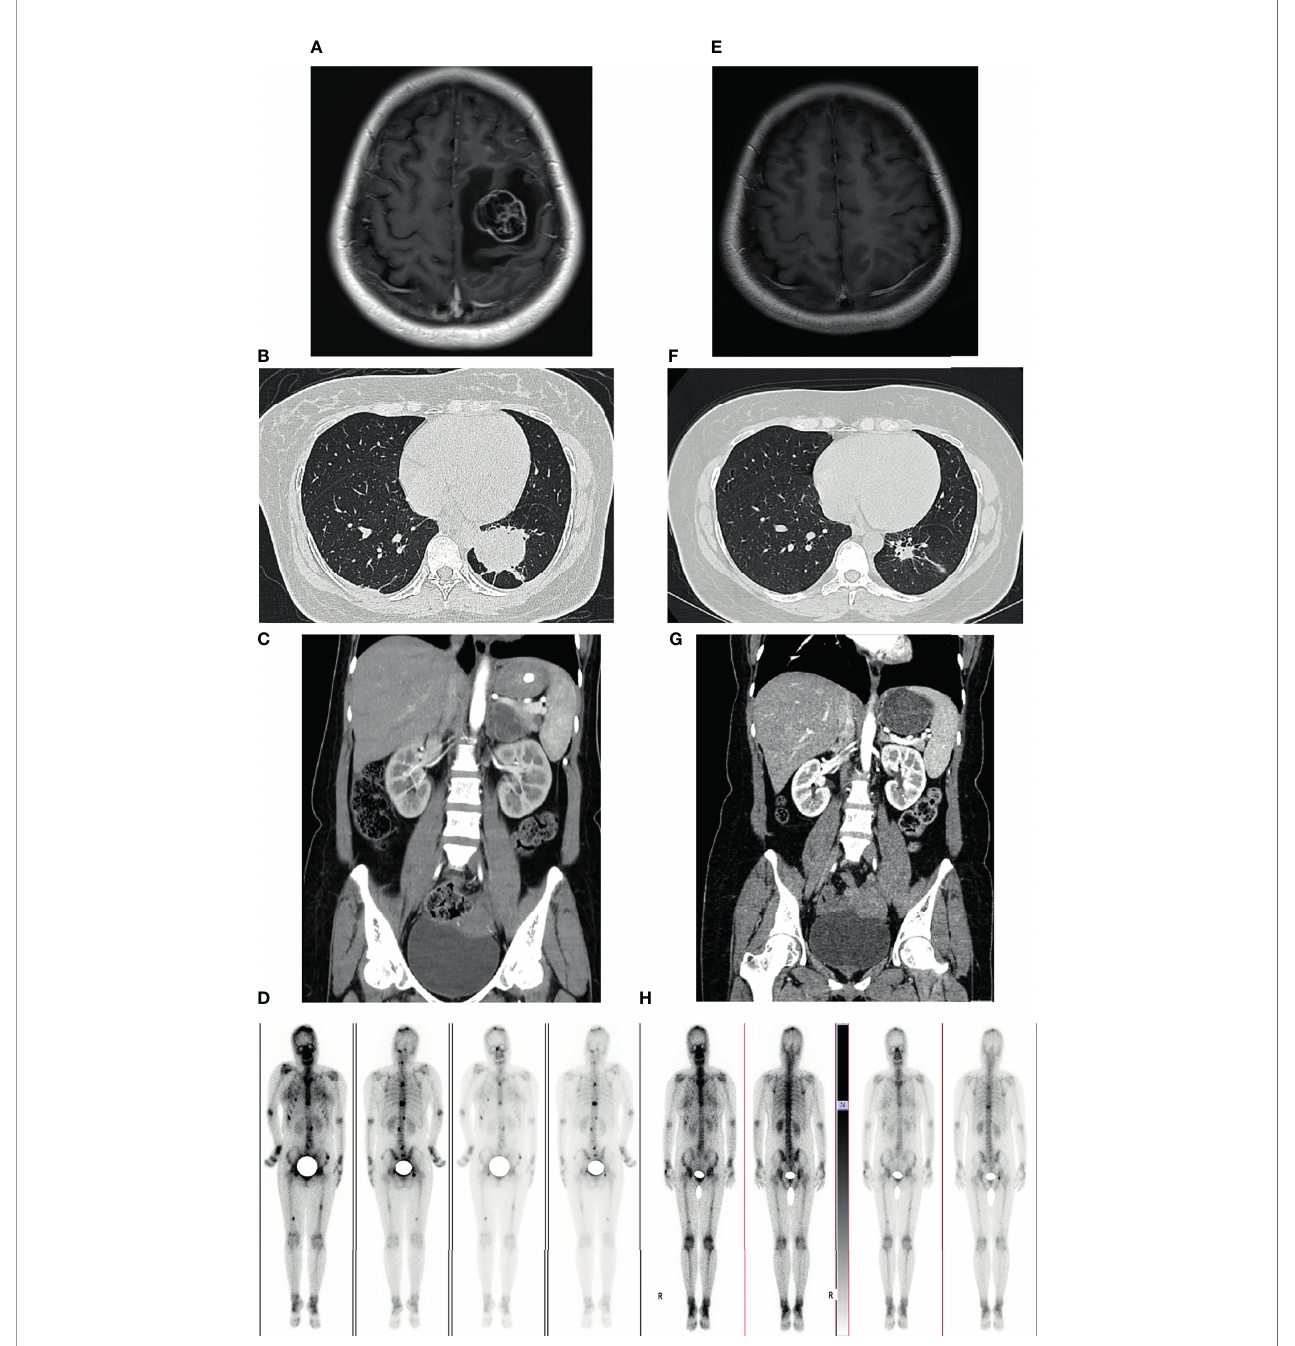
FIGURE 1 | Imaging examinations before craniotomy and alectinib treatment (A – D) . 10-months follow-up radiological evaluation (E – H) . (A) Contrast-enhanced cranial MRI showed the lesion in the left frontal lobe. (B) CT scan of the chest showing the mass in left lower lobe of the lung. (C) CT enhancement scan showing the mass in the left adrenal. (D) 99mTc-MDP bone scintigraphy demonstrating multiple lesions of increased activity in spine, pelvis, skull, ribs, skull and femurs. (E – H) Radiological evaluation demonstrating a dramatical shrinkage of all known lesions after 10